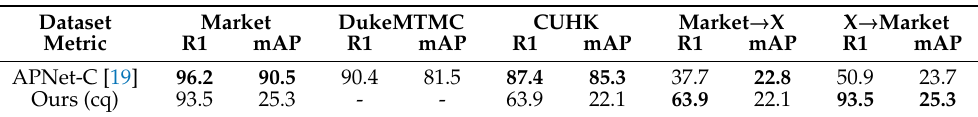
Table 6. Comparison between single-domain and cross-domain accuracies of supervised DL CNN models with the proposed